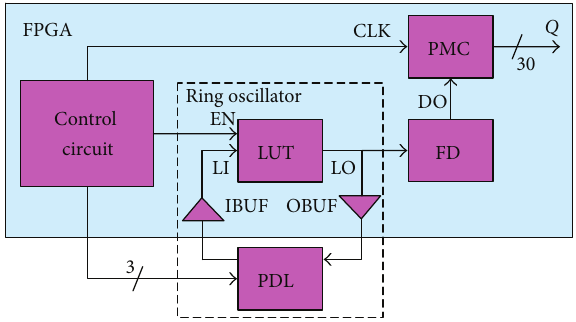
Figure 1: Block diagram of the proposed FPGA-integrated TDC.